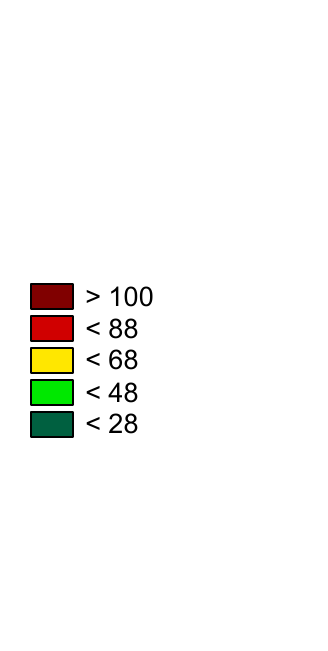
Figure 5. Distribution of indicator values for access to clean fuels and technologies for cooking (% of population) and access to electricity (% of urban population) in relation to classification by levels of all indicators from 2000 to 2019. Source: own study.